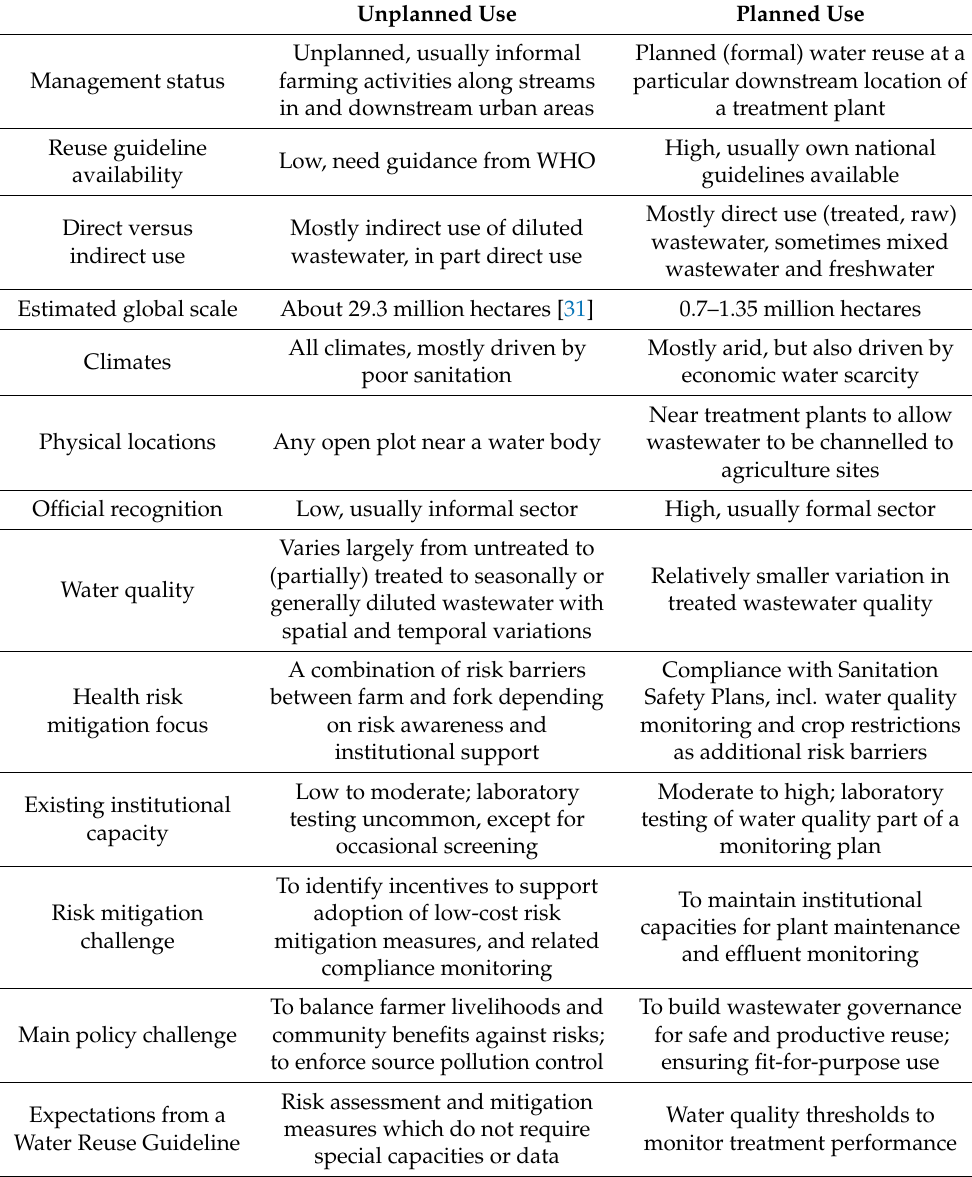
Table 2. Characteristics of two principal wastewater irrigation